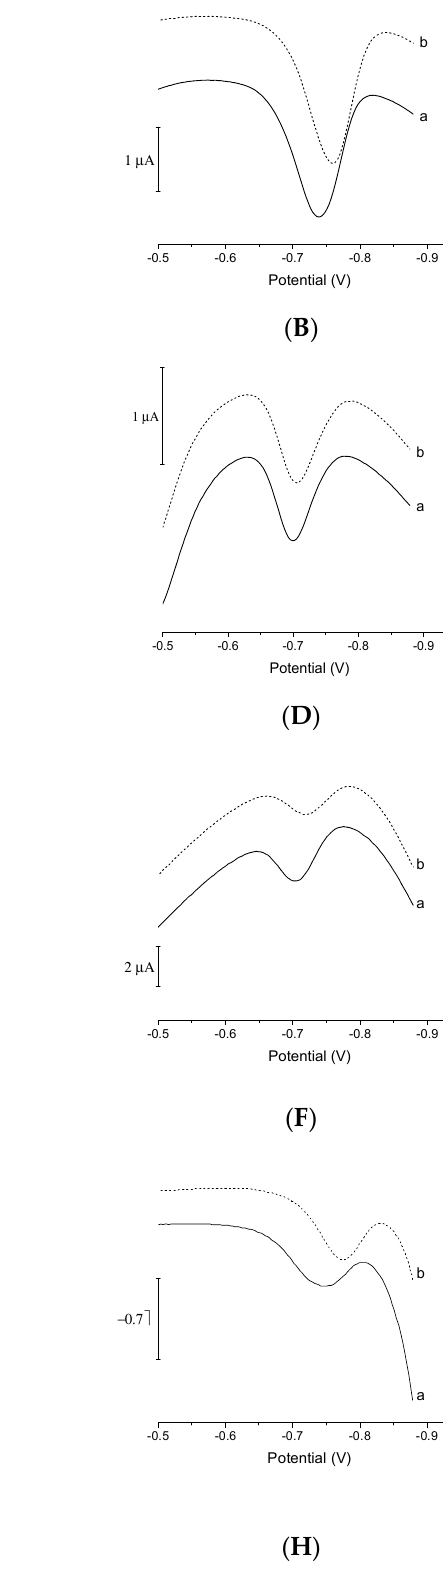
Figure 5. The first (a) and tenth (b) voltammogram recorded in a solution containing 30 nM of Ge(IV) ( A − F ) or 300 nM of Ge(IV) ( G , H ) using bismuth films plated on GC ( A ), carbon SPE ( B ), mesoporous carbon SPE ( C ), ordered mesoporous carbon SPE ( D ), graphene SPE ( E ), reduced graphene oxide SPE ( F ), carbon multifiber electrode ( G ), and bismuth-sputtered electrode ( H ). Other parameters as in Figure 1.